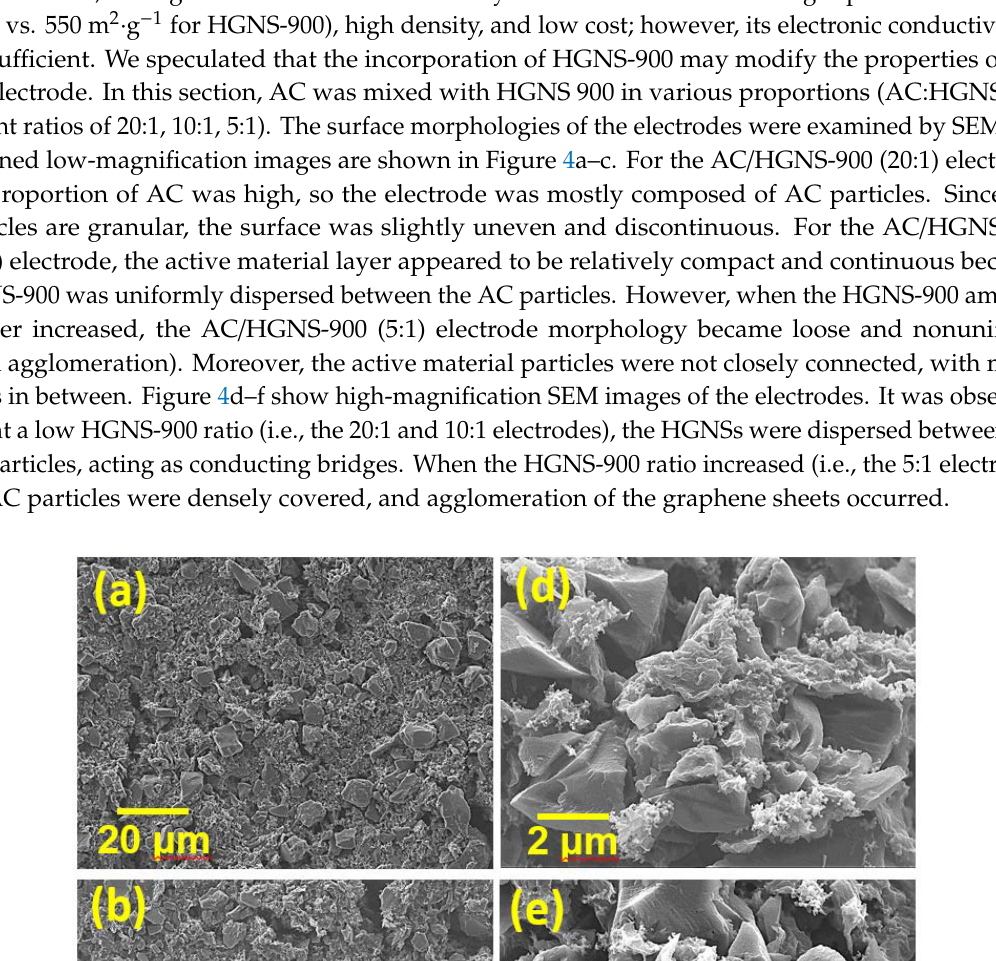
Figure 4. Low-magnification SEM images of ( a ) AC/HGNS-900 (20:1); ( b ) AC/HGNS-900 (10:1); and ( c ) AC/HGNS-900 (5:1) electrodes. High-magnification SEM images of ( d ) AC/HGNS-900 (20:1); ( e ) AC/HGNS-900 (10:1); and ( f ) AC/HGNS-900 (5:1) electrodes. The surface area plays a vital role in determining the EDLC performance. In order to better understand the effects of HGNS-900 incorporation on the electrode specific surface area, N 2 adsorption/desorption measurements of the electrode coating layers were performed. As shown in Figure 5a, the calculated BET surface area of the AC electrode was 917 m 2 ·g –1 , which is considerably lower than that of AC powder (i.e., 2000 m 2 ·g –1 ). This reflects the fact that the AC particles agglomerated after slurry coating and drying. Additionally, the electrode binder may block the pores of AC, thereby reducing the surface area. The surface area for AC/HGNS-900 (20:1) reached 968 m 2 ·g –1 , indicating that the incorporation of HGNS could alleviate the AC aggregation and pore blocking problems. However, with further increasing the HGNS-900 ratio, the BET surface area decreased (e.g., 784 m 2 ·g –1 for AC/HGNS-900 (10:1)) because the intrinsic specific surface area of HGNS-900 is lower than that of AC. The surface area of AC/HGNS-900 (5:1) was reduced to 635 m2·g –1 , since the AC surface was covered by agglomerated graphene sheets that shielded the AC pores (see Figure 4f). Figure 5b shows the pore size distribution of various electrodes. It was confirmed that the incorporation of HGNS can create meso- and macro-pores between AC particles. Nevertheless, if the proportion of the macro-pores is too high (i.e., AC/HGNS-900 (5:1)), the electrode becomes loose and discontinuous (see Figure 4c).